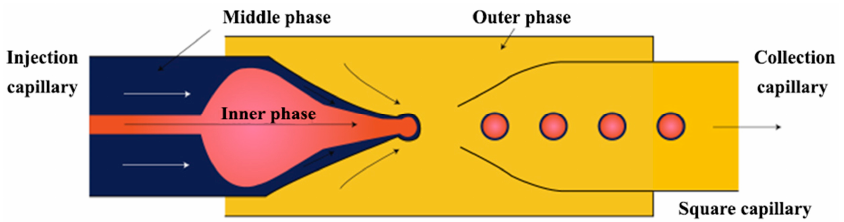
Figure 16. Glass capillary device for the formation of thin shelled drops. The middle phase has a higher affinity towards the wall of the outer injection capillary and flows in a thin layer along the wall of the outer capillary pushed by the inner phase injected at high flow rate through the innermost capillary [31].